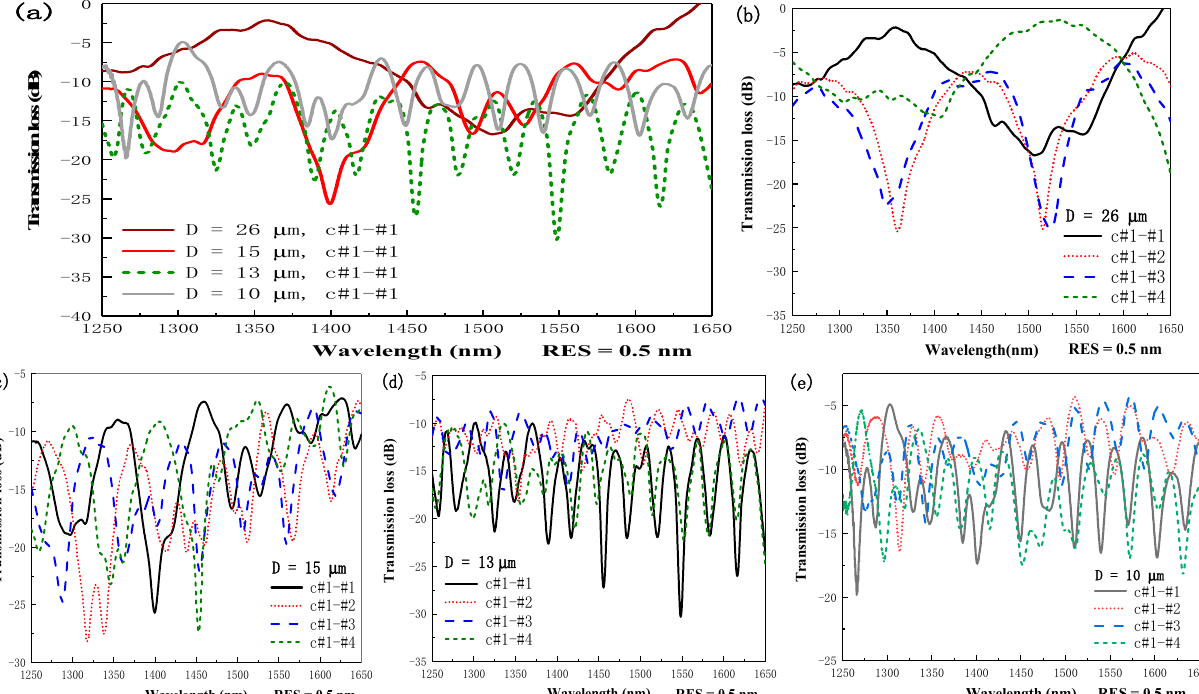
Figure 3. Spectral responses of the oscillating curves for ( a ) D = 26, 15, 13, 10 μ m with the c#1-#1 states and for ( b ) D = 26 μ m, ( c ) D = 15 μ m ( d ) D = 13 μ m, and ( e ) D = 10 μ m with the c#1-#1/2/3/4 states.